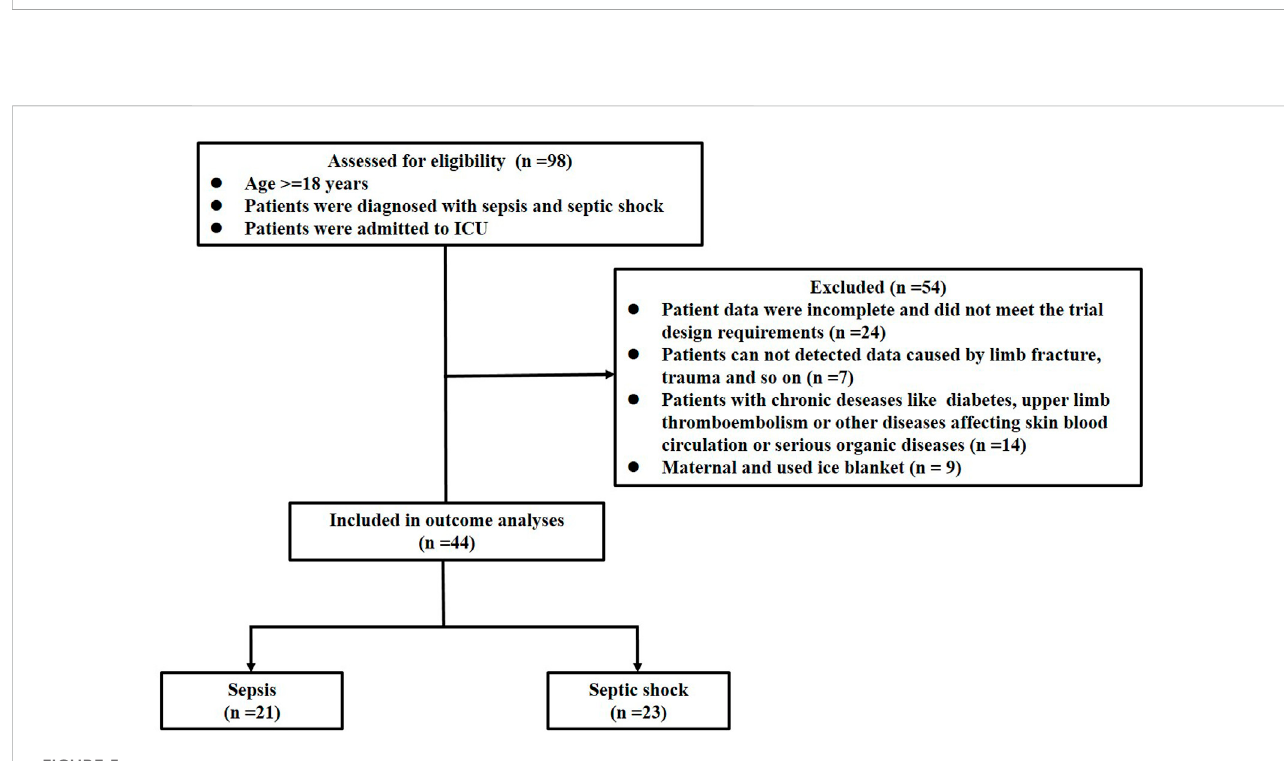
FIGURE 5 Flowchart of trial